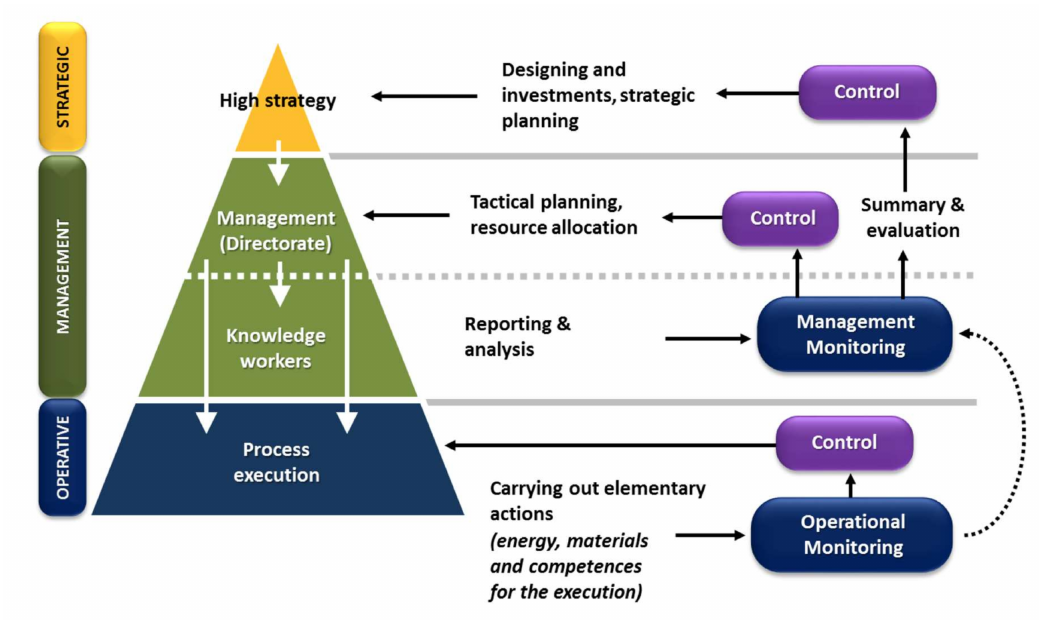
Figure 3. Schematization of the hierarchical levels of an enterprise and indication of the main tasks of the responsible people at each level (derived from